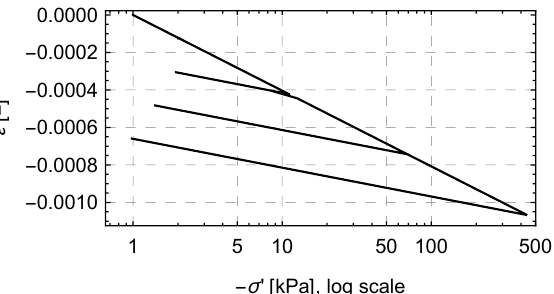
Figure 8. Relationship between log σ (cid:48) and strain produced by the model for η = 0.